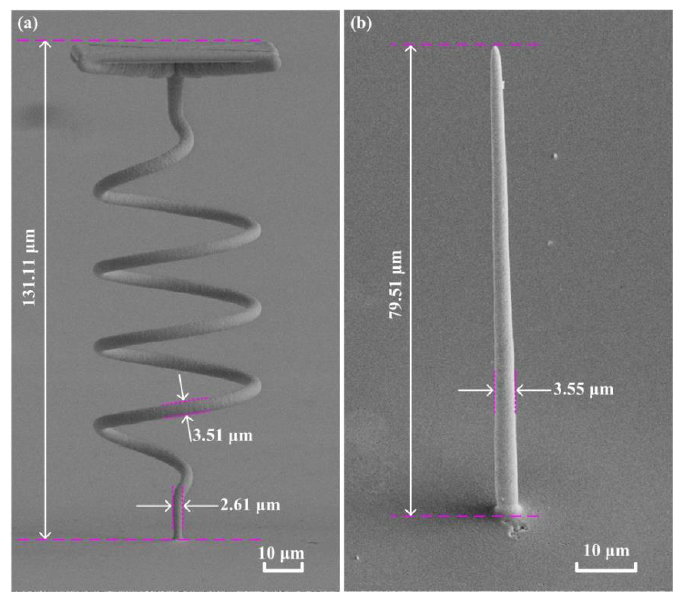
Figure 2. The high aspect ratio structures had been fabricated by localized electrochemical deposition and the aspect ratio is higher than 20. ( a ) a helix with flat surface. ( b ) a micro fine needle.